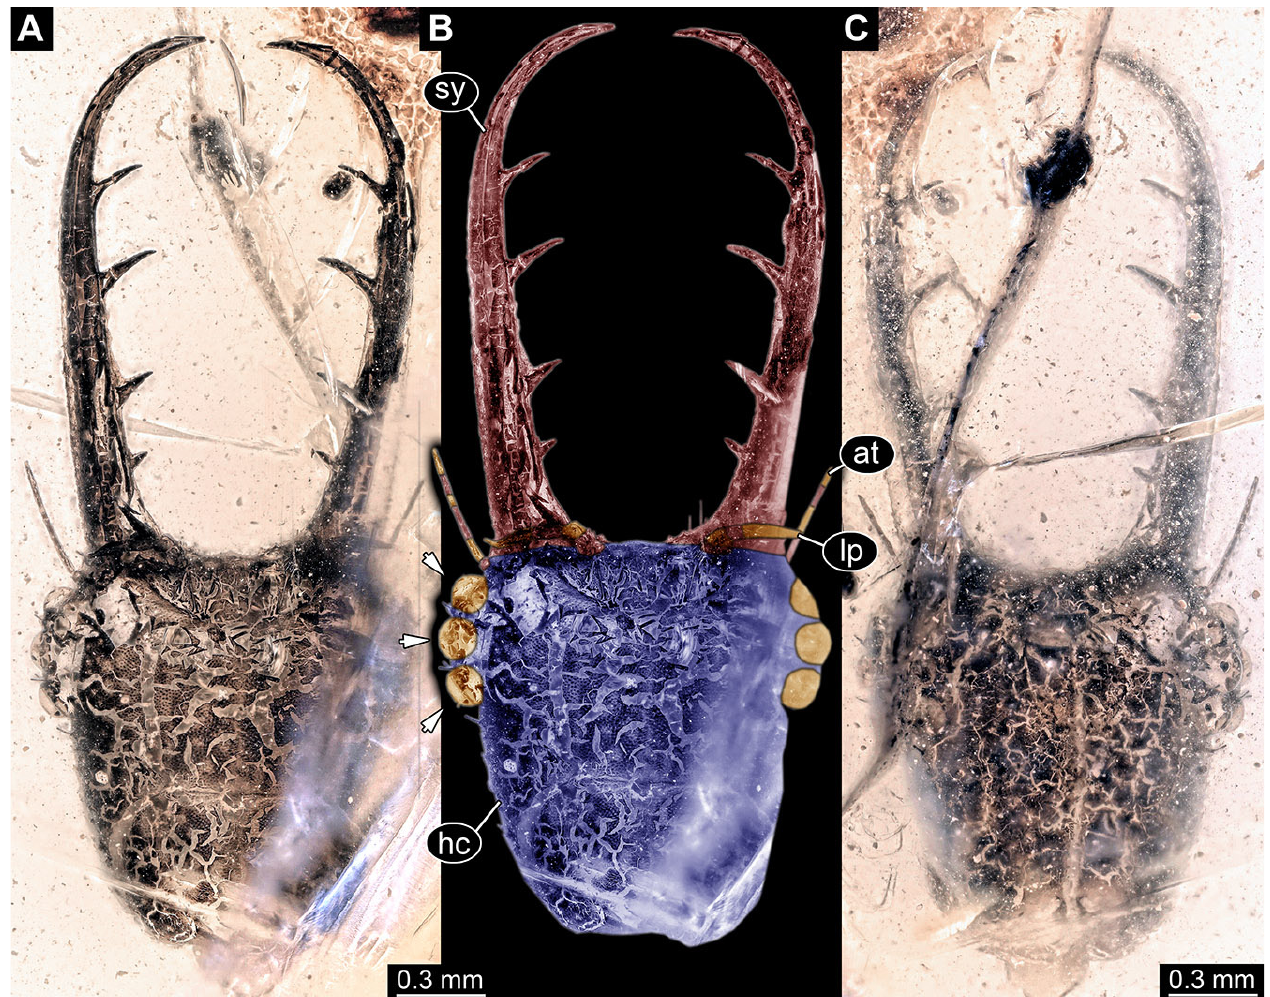
Figure 2. Fossil owllion larva, specimen 3213 (IGR.ARC-236.3), Cretaceous Charentese amber, France. ( A ) Overview, ventral. ( B ) Color-marked version of ( A ); arrows indicate individual stemmata. ( C ) Overview, dorsal. Abbreviations: at = antenna; hc = head capsule; lp = labial palp; sy = stylet.